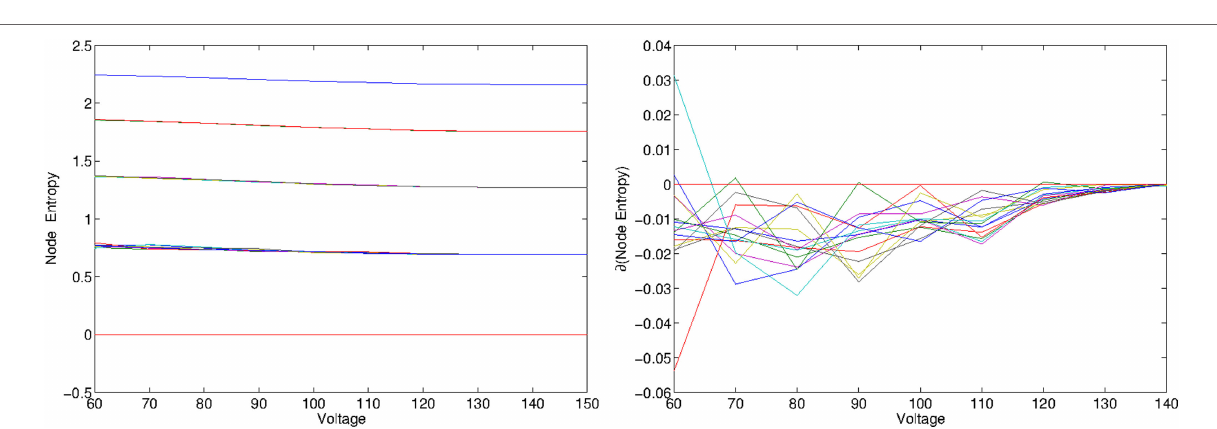
FIGURE 10 | Left: average Node entropy evaluated from a Monte Carlo simulations over 100 instances, for L =5 layers . The voltage is varied from V = 60 to V = 150 in steps of 10V. Right: plot the derivative of the entropy with respect to the input voltage. We observe that for large values of the voltage, the derivative converges to zero. Multiple simulations have shown that the value of V where the derivative crosses zero is not universal, but indeed depends on the parameters used for the